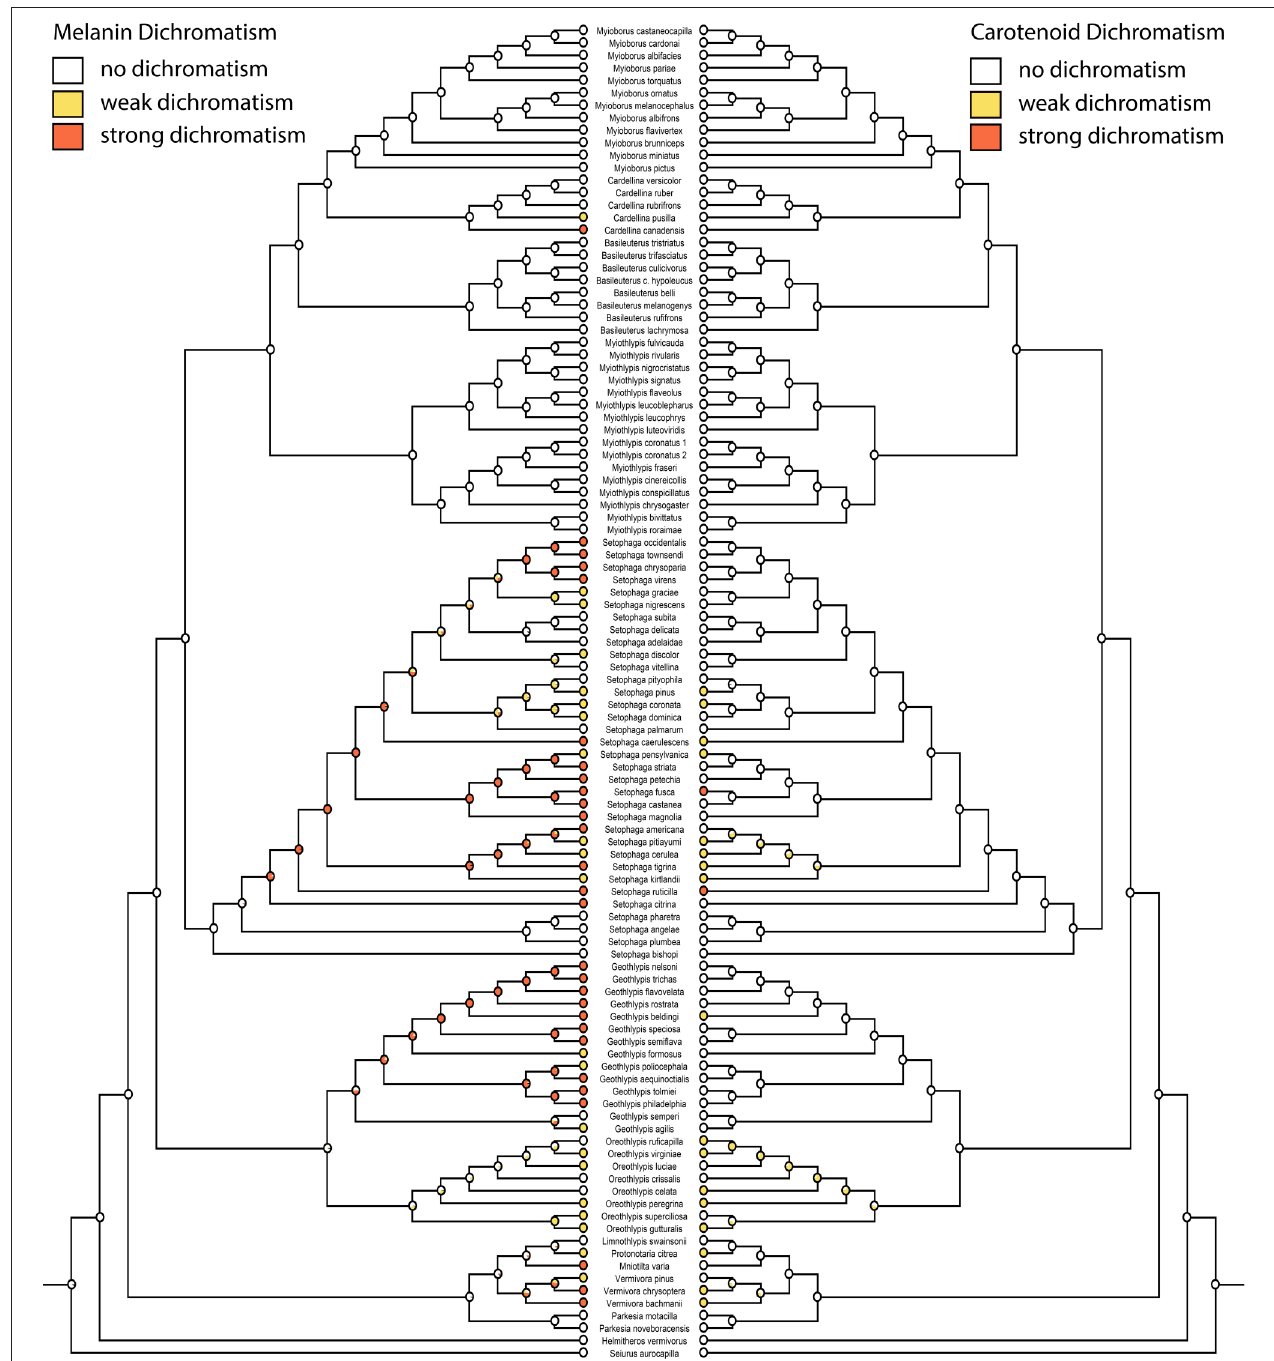
FIGURE 4 | Ancestral state reconstructions of melanin dichromatism 2 (mk1, log likelihood: − 86.99) on the left mirrored with carotenoid dichromatism 2 (mk1, log likelihood: − 68.94) on the right. White circles are monochromatic, yellow circles weakly dichromatic, and red circles strongly